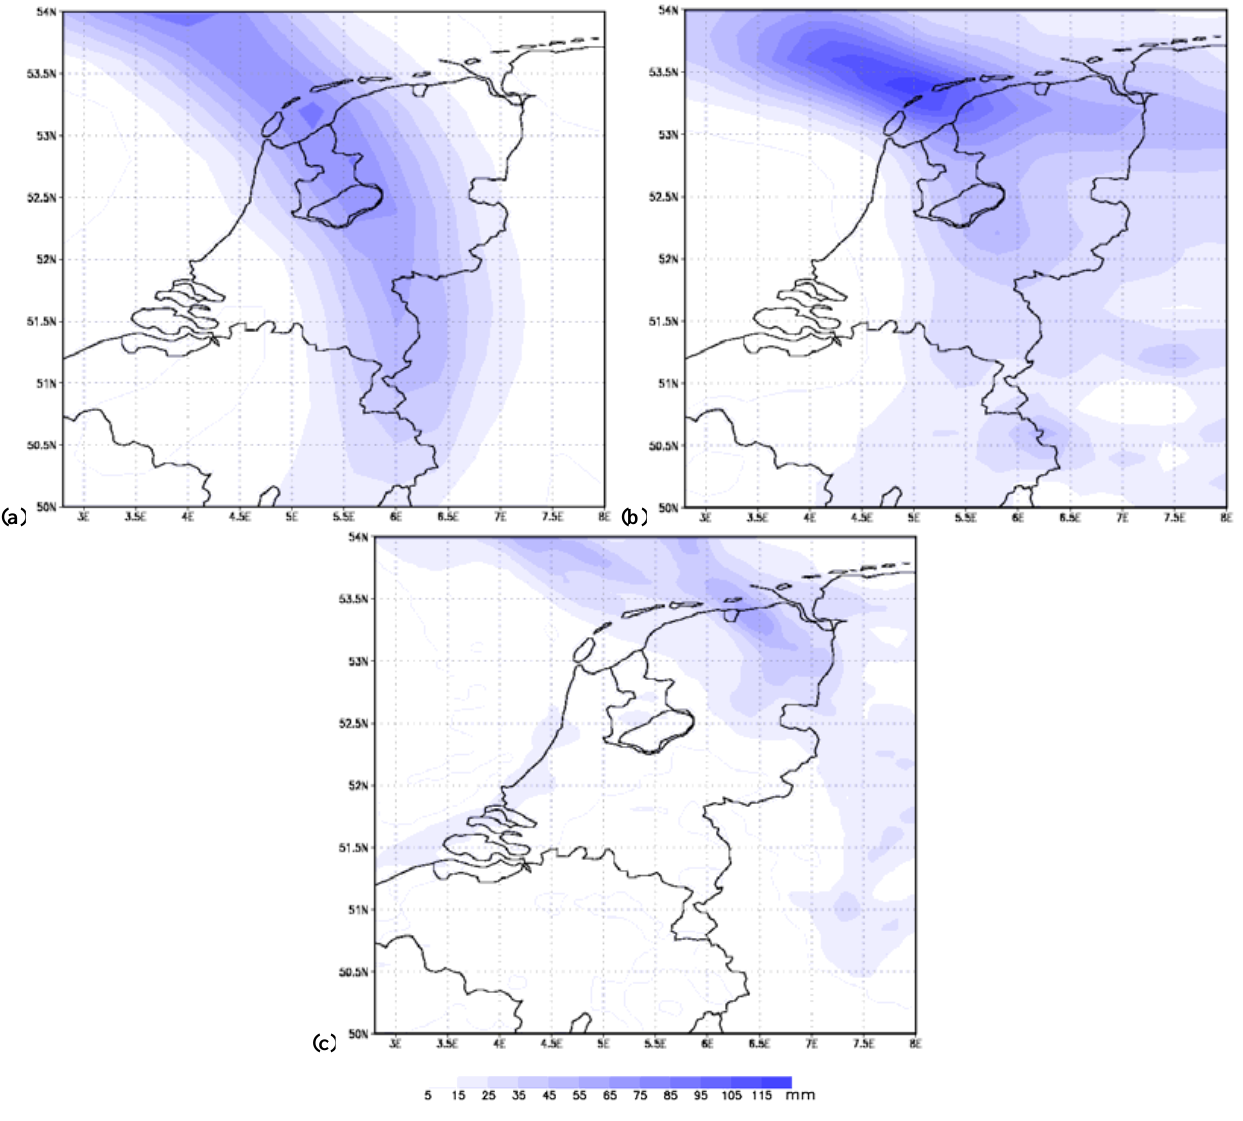
Fig. 7. Accumulated precipitation amounts (mm), calculated by the operational numerical weather prediction models ECMWF (a) and HIRLAM (b) and the non-hydrostatic mesoscale model MM5 (c) , over the time period between 12 August 2004 12:00 UTC and 13 August 2004 12:00